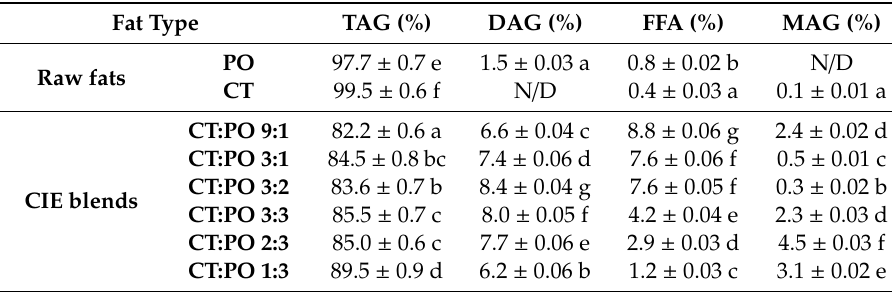
Table 3. Polar and nonpolar fraction content of the raw fats and interesterified